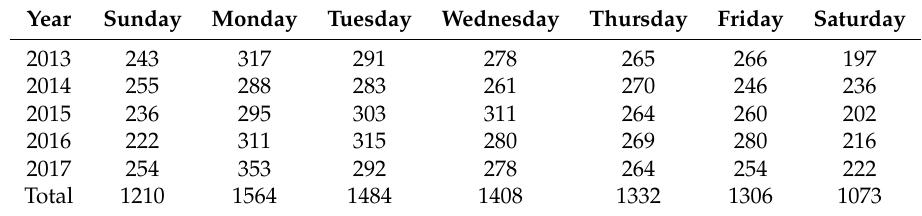
Table 13. Number of suicides among the general Dutch population for each day of the week over the period